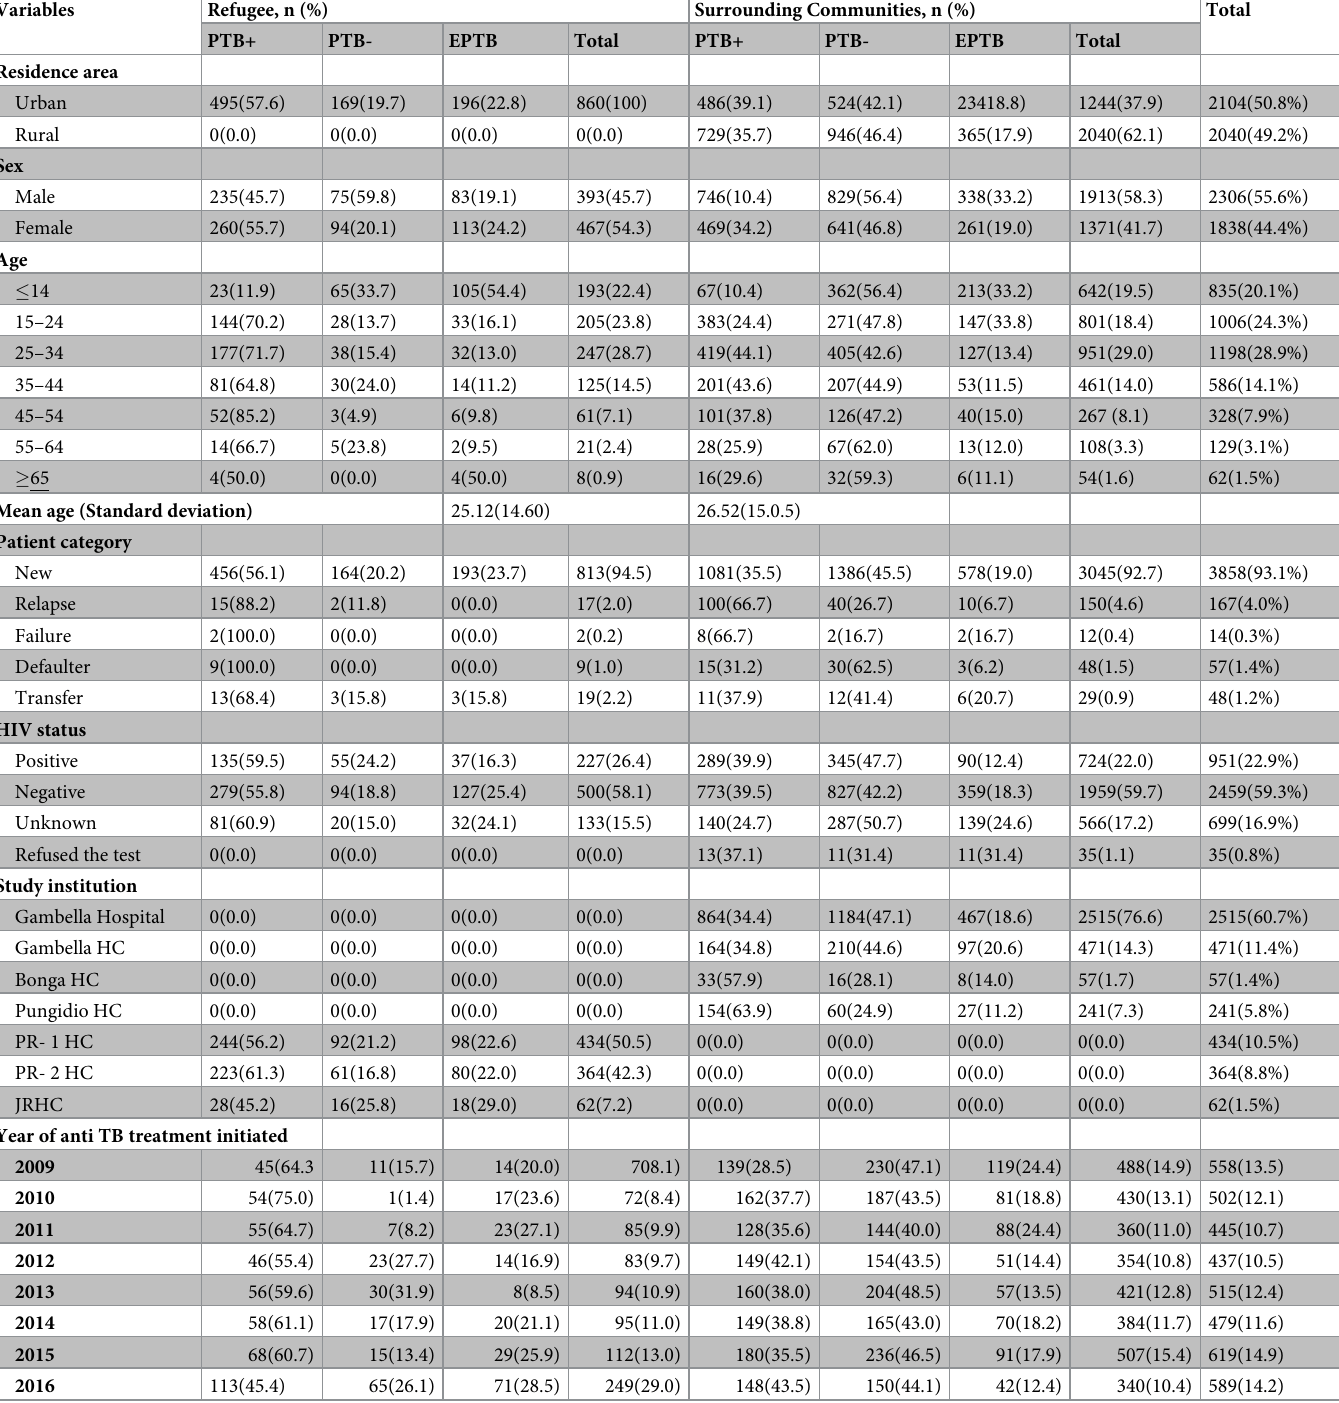
Table 1. Socio-demographic characteristic of refugees and surrounding communities registered TB cases (n = 4144) in Gambella Regional State, South West Ethio- pia,